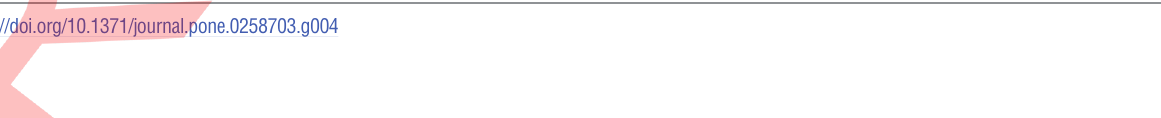
PLOS ONE | https://doi.org/10.1371/journal.pone.0258703 November4,